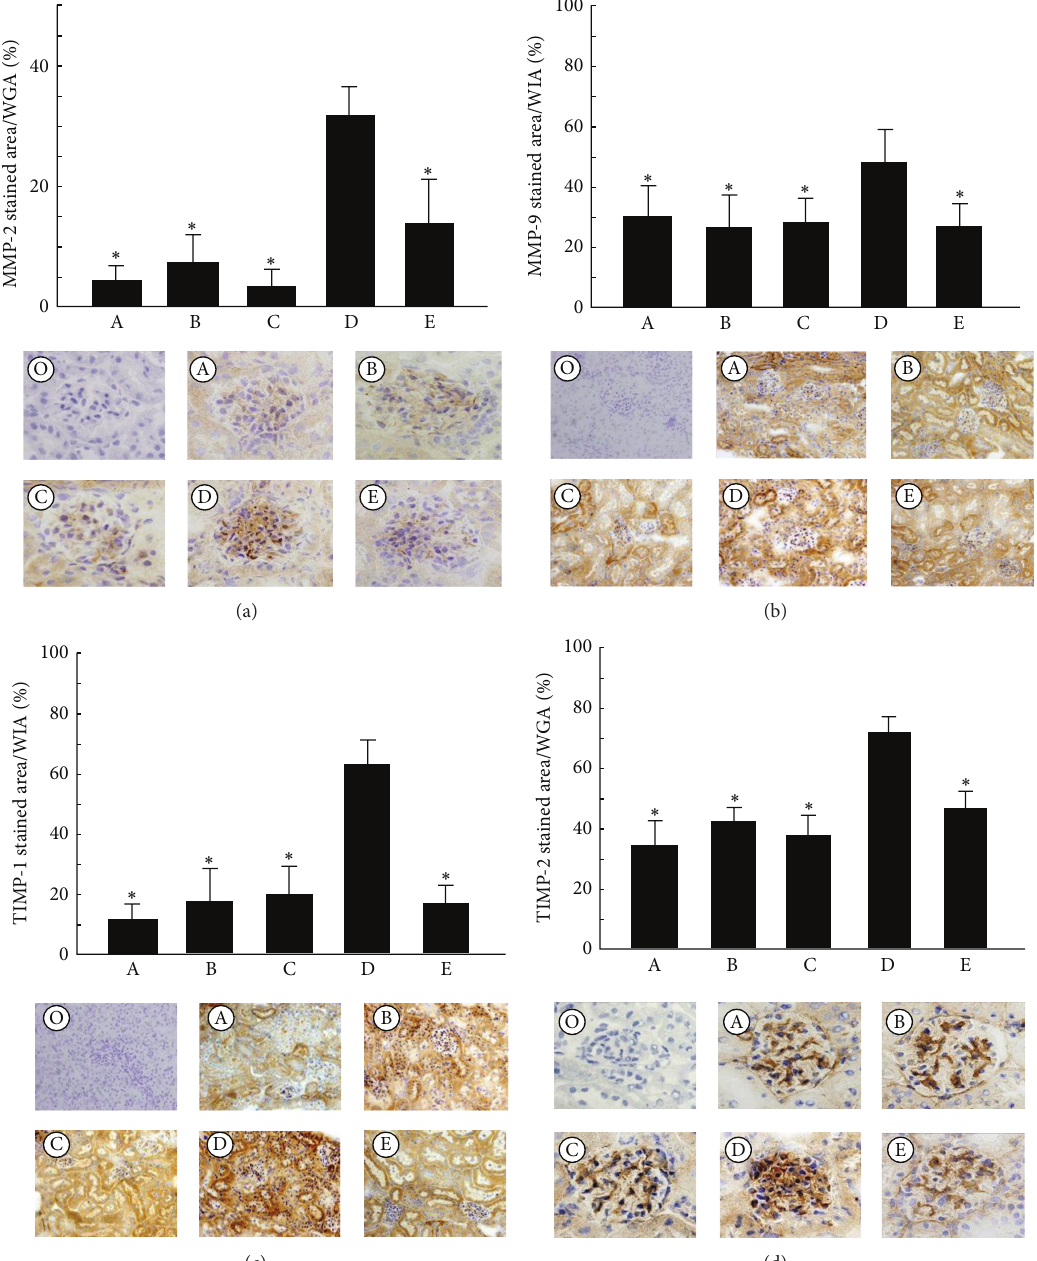
(d) Figure 2: Immunohistochemical staining of MMP-2, MMP-9, TIMP-1, and TIMP-2 in the renal sections of each mouse (O: untreated KK- 𝐴 𝑦 mice at 12 weeks of age without primary Ab, A: untreated KK mice at 8 weeks of age, B: untreated KK mice at 12 weeks of age, C: untreated KK- 𝐴 𝑦 mice at 8 weeks of age, D: untreated KK- 𝐴 𝑦 mice at 12 weeks of age, and E: treated KK- 𝐴 𝑦 mice at 12 weeks of age). Stainings showing the expression of MMP-2 (a), MMP-9 (b), TIMP-1 (c), and TIMP-2 (d) in the kidneys of mice from each group. These expressions were increased significantly in group 4 compared with groups 1, 2, and 3. This increase was attenuated in group 5 ( ∗ 𝑃 < 0.001 versus untreated KK- 𝐴 𝑦 mice at 12 weeks of age). Images were taken at 400-fold (a and d) and 200-fold (b and c) magnification. WGA indicates whole glomerular area. WIA indicates whole interstitial